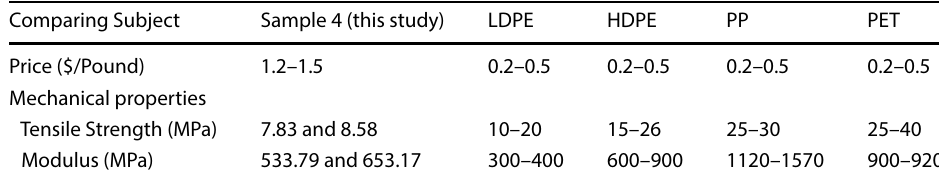
Table 9 Comparison with different synthetic